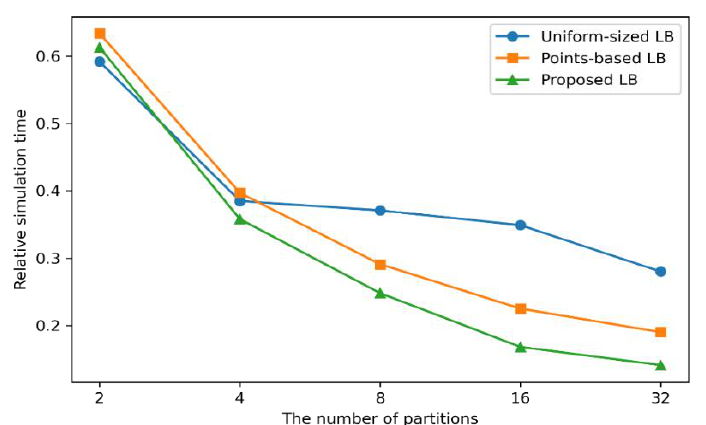
Figure 12. The experimental results by the number of